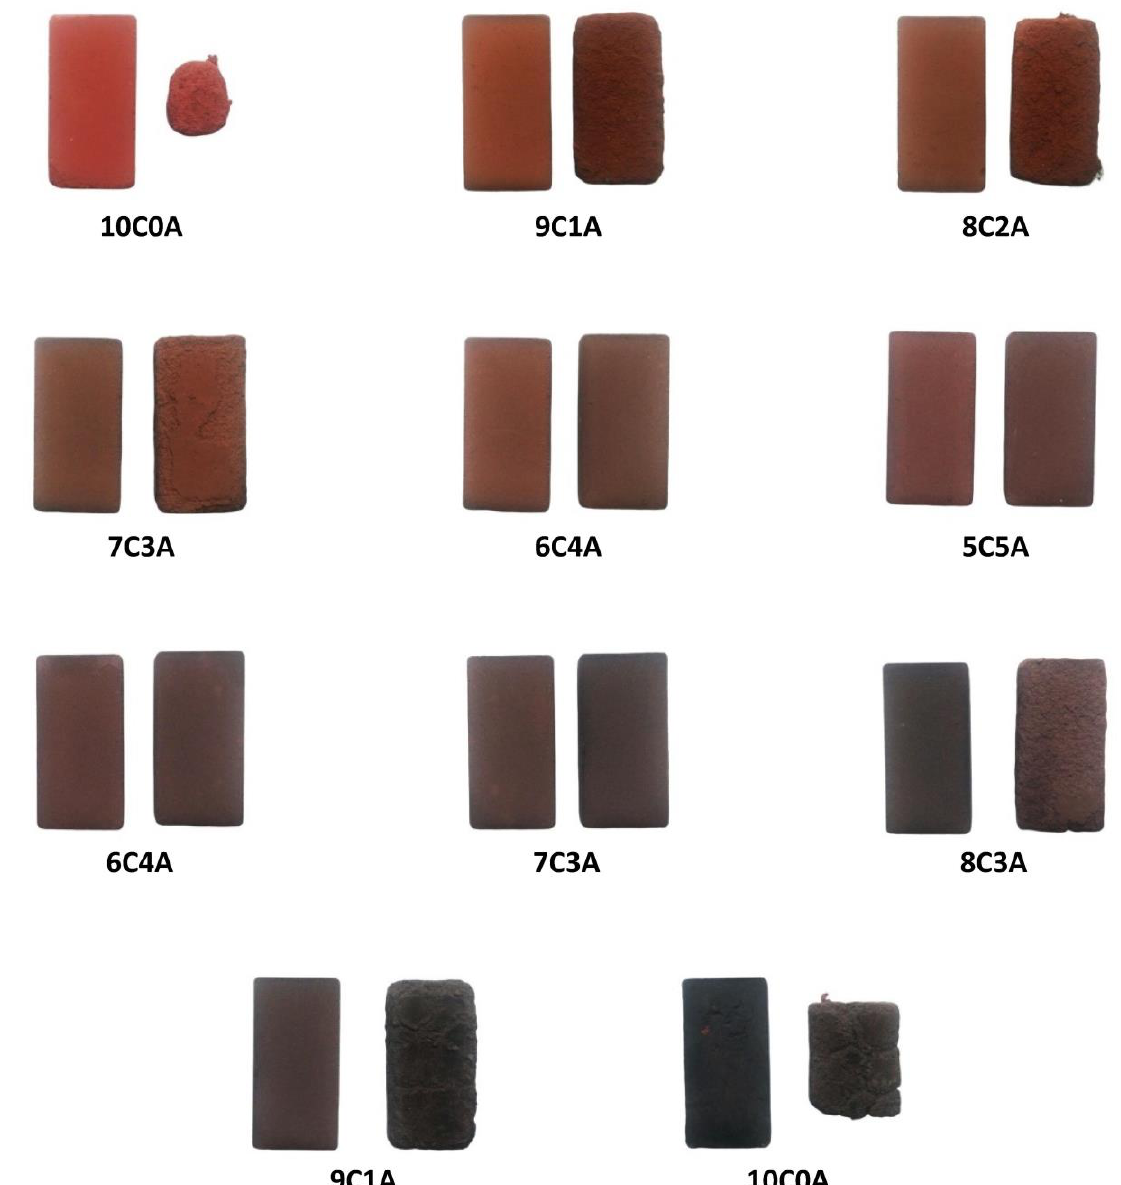
Figure 6. Image of the samples before the freezing test (left) and after the freezing test (right) for each of the geopolymer families studied.